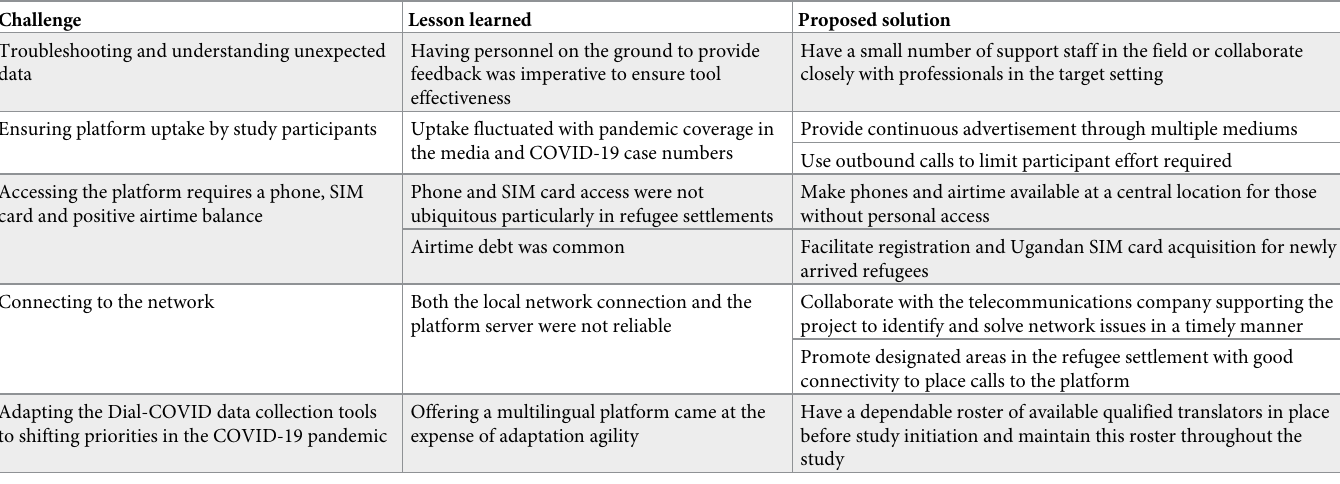
Table 2. Lessons learned implementing